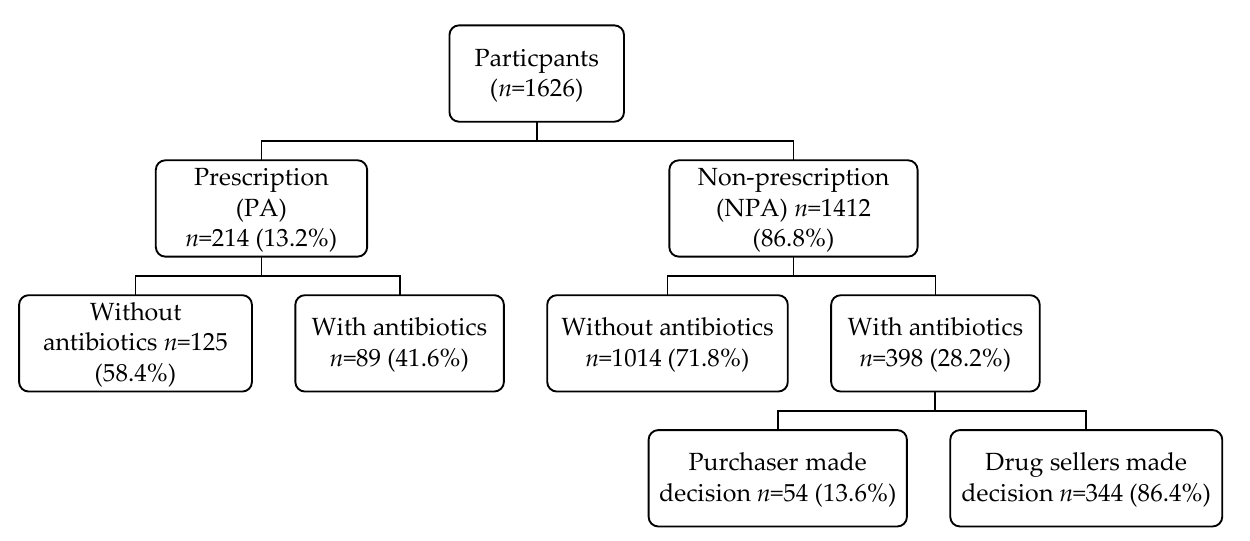
Figure 1. Flow chart of participants.